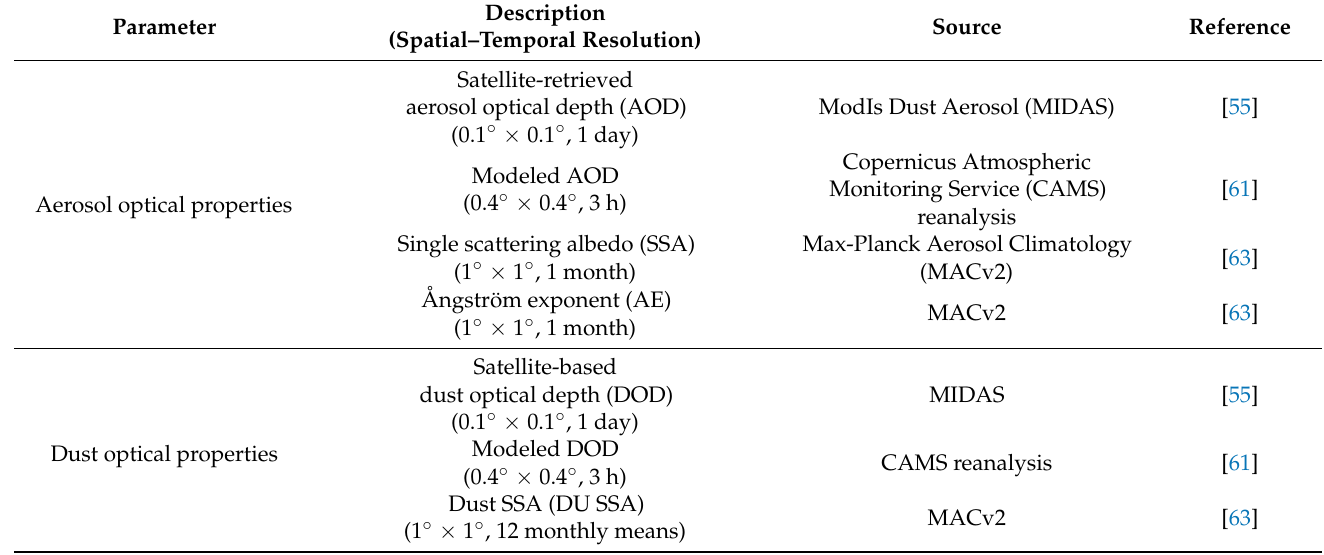
Table 1. Datasets of total aerosol and dust optical properties and key atmospheric parameters